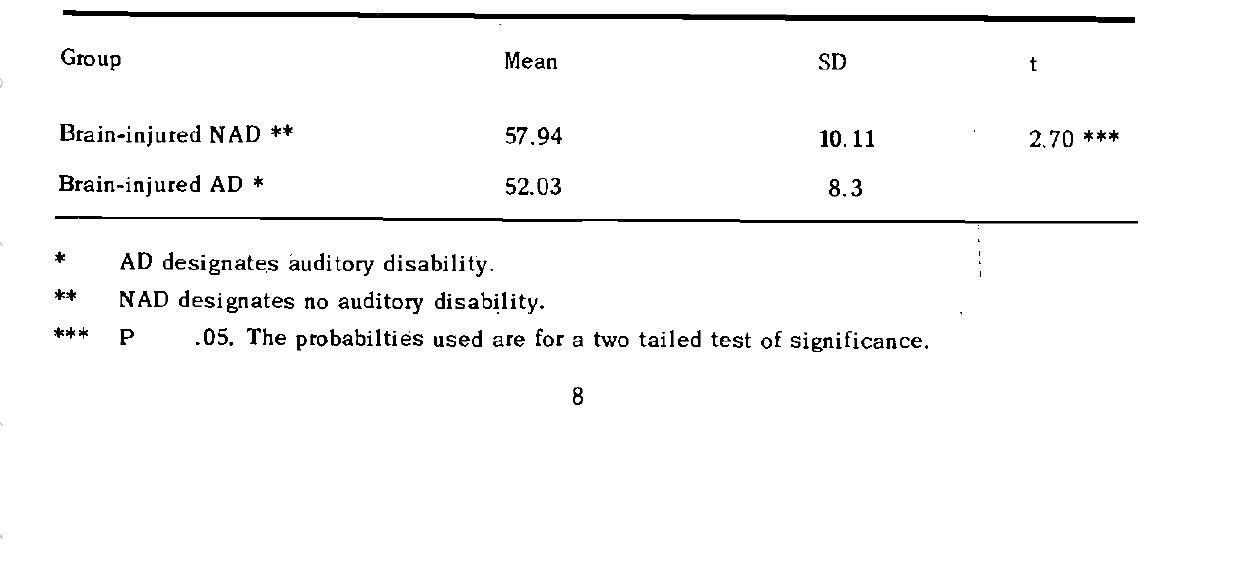
Performance of the Matched Pairs of Mentally Retarded Brain-injured Children on Tone Judgements.